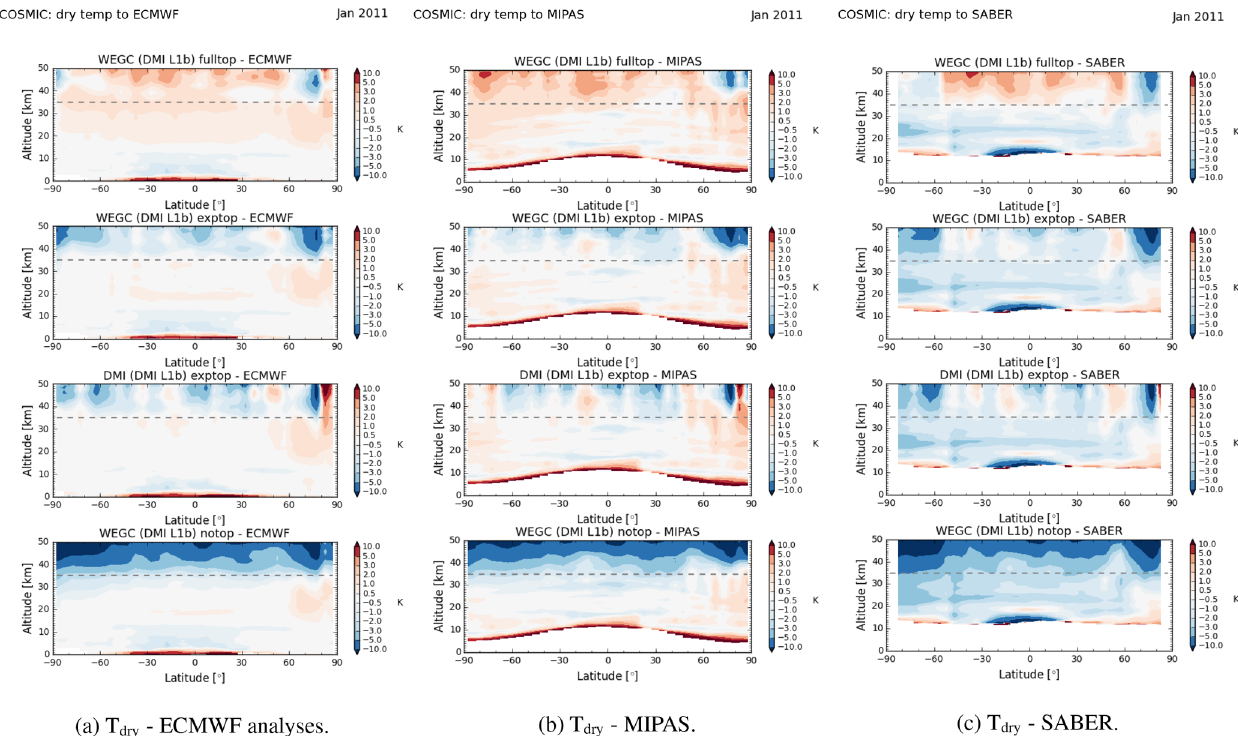
Figure 11. API dry-temperature differences relative to different reference climatologies, comparing API processing between WEGC and DMI for different high-altitude extrapolations (fulltop, exptop, notop), for January 2011.